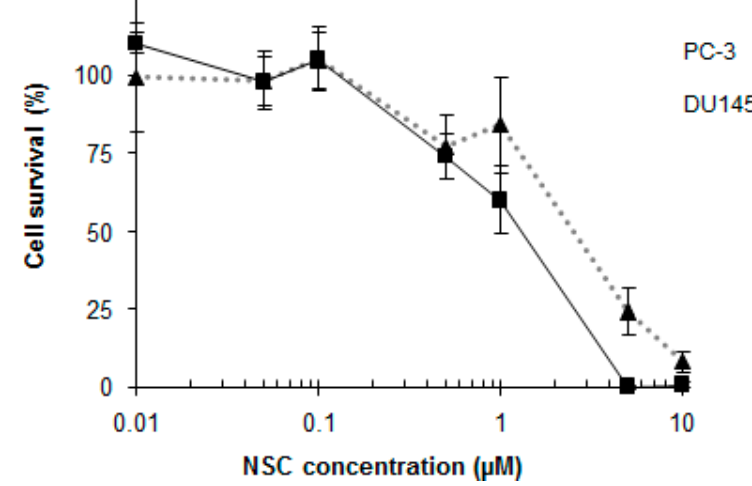
Figure 7. PC-3 and DU145 cell survival is dose-dependent in NSC-treated cells. PC-3 cells (dashed gray line) and DU145 cells (black line) were incubated with different concentrations of NSC for 72 h and cellular viability was measured by the MTT method. The 50% inhibitory concentration (IC 50 ) of NSC was calculated by nonlinear regression analysis using GraphPad Prism software. The bars represent the mean ± SD of 3 independent experiments.